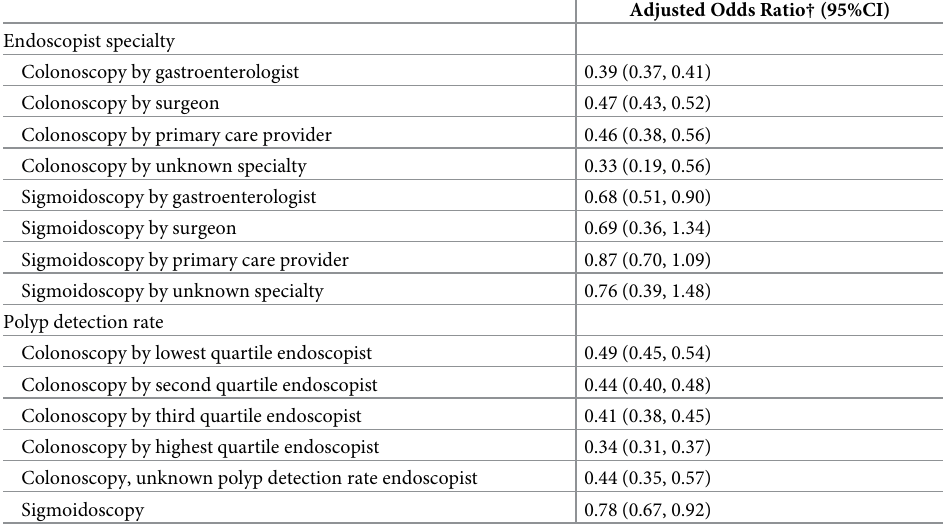
Table 4. Endoscopist characteristics in relation to the magnitude of the association of CRC incidence and screen- ing endoscopy history, SEER-Medicare �